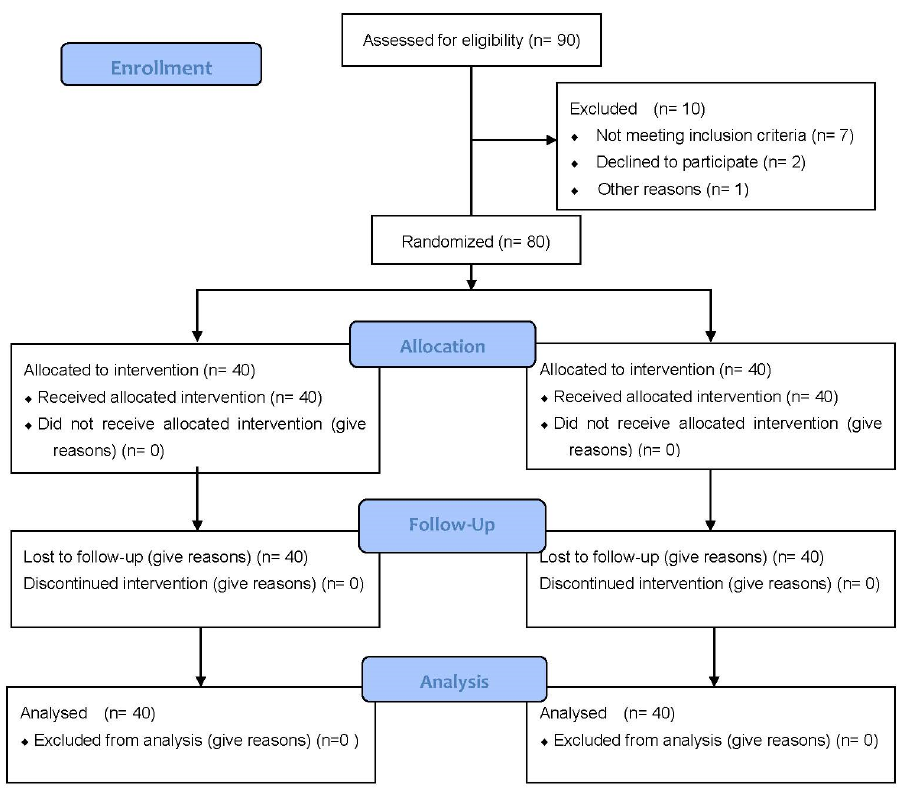
Figure 1. Flow Diagram.